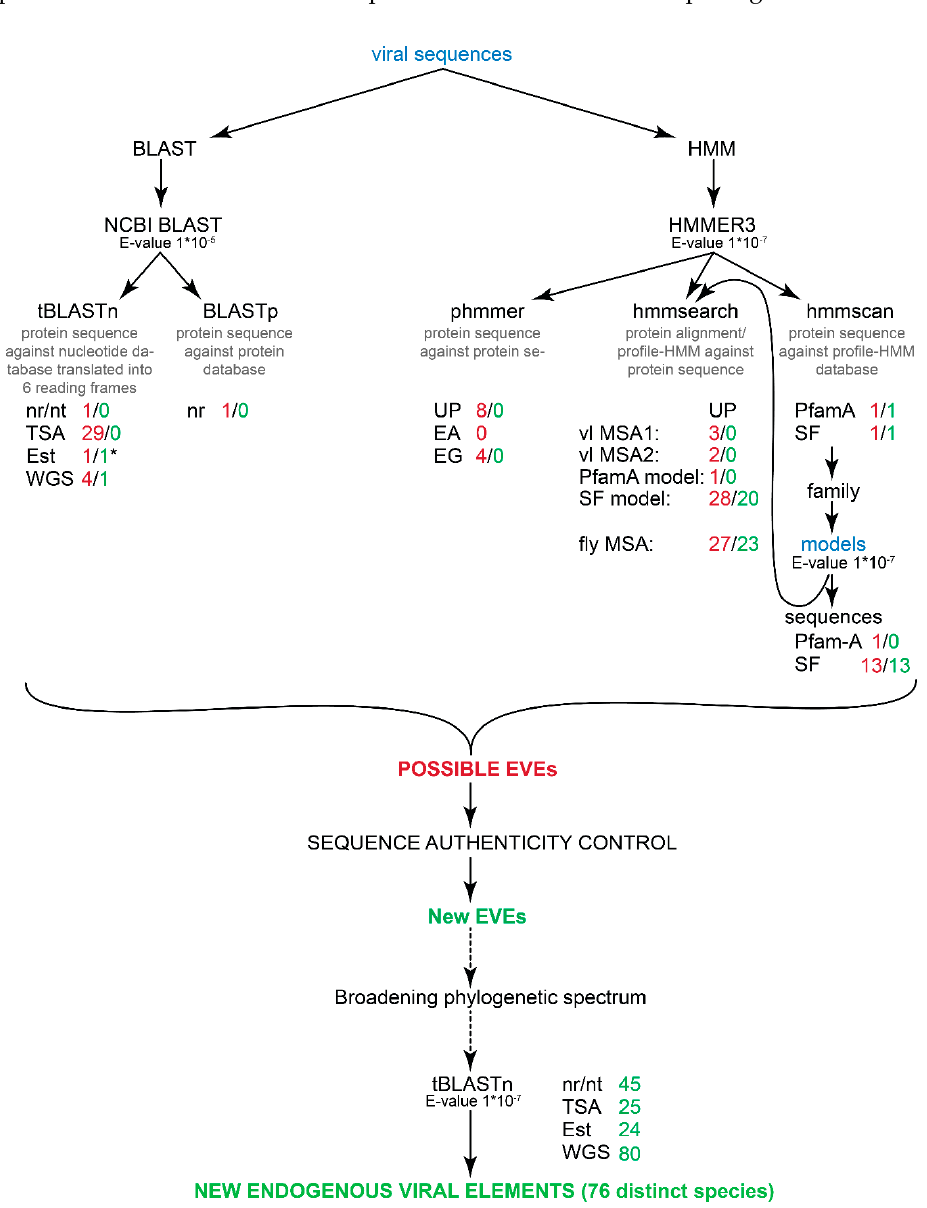
Figure 1. Workflow of the identification of new EVEs. The first step is the search against eukaryotic sequences from different databases (the Swiss-Prot database results are left out because this database gave no hits) using viral sequences as a query. All the search inputs (sequences and models) are indicated in blue script. All the hits are then examined to determine false positives and mis-annotations. All the numbers after the databases (written in red) indicate the distinct hit IDs that were collected from the databases. The second number (written in green) indicates (after all the noted sequence authenticity controls) how many possible EVEs were identified from the databases. The “*” denotes one recombinant sequence that was found in the analyses. “vl MSA1” denotes Tobamovirus -specific MSA, “vl MSA2” denotes Tobamovirus - Hordeivirus - Pecluvirus - Tobravirus specific MSA and “fly MSA” denotes an MSA that was constructed using 13 Drosophila fly sequences from the SUPERFAMILY database. Abbreviations: UniProtKB, UP; Ensembl All, EA; Ensembl Genomes, EG; SUPERFAMILY, SF. Note that “nr” database in BLASTp search include also UniProtKB. The sequence authenticity control workflow is described in detail in Figure 2.